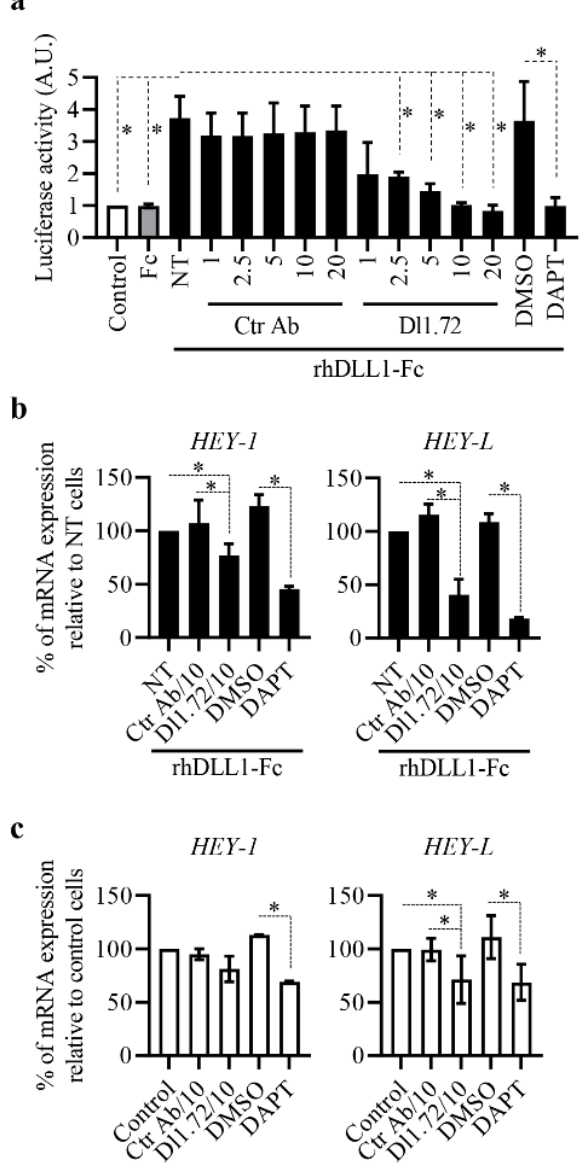
Figure 2. Anti-DLL1 Dl1.72 impairs DLL1-Notch signaling in MCF-7 cells. ( a ) Notch luciferase reporter assay. Cells transfected with the Notch firefly luciferase reporter were cultured for 28 h in uncoated (control) wells or wells pre-coated with Fc control protein or rhDLL1-Fc in the absence (NT) or presence of the indicated concentration (µg/mL) of Dl1.72, Ctr Ab, the pan-Notch inhibitor DAPT (5 µM) or DMSO (DAPT vehicle). The graph shows luciferase activity (mean ± SD, n = 3) compared to control unchallenged cells. ( b ) Effect of Dl1.72 on the levels of HEY-1 and HEY-L induced by DLL1. Cells were cultured in wells pre-coated with rhDLL1-Fc proteins and not treated (NT) or treated with Dl1.72, Ctr Ab (10 µg/mL each), DAPT or DMSO. After 17–20 h, the transcript levels of Notch-dependent genes HEY-1 and HEY-L were determined by RT-qPCR. Graphs show the mean percentage (±SD, n = 3) of HEY-1 and HEY-L mRNAs relative to untreated cells. ( c ) Effect of Dl1.72 on the basal levels of HEY-1 and HEY-L . MCF-7 cells were cultured in the absence (control) or presence of Dl1.72, Ctr Ab (10 µg/mL each), DMSO or DAPT, and the transcript levels were determined as above. Graphs show the mean percentage (±SD, n > 3) of HEY-1 and HEY-L mRNAs relative to unstimulated control cells. *, p < 0.05 (two-tailed paired Student t -test).